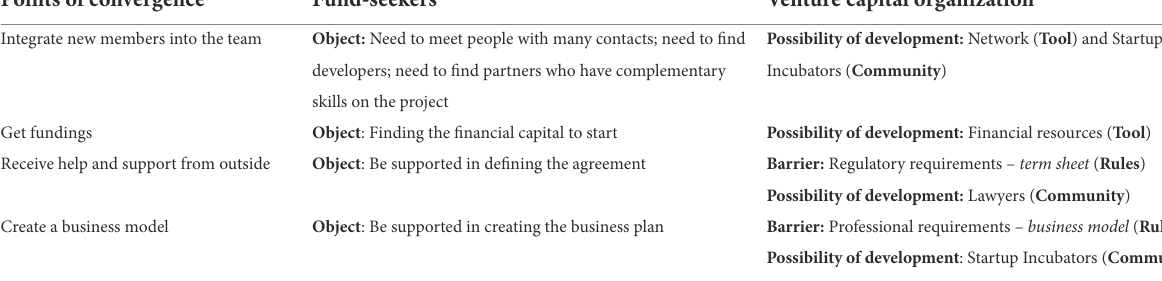
TABLE 1 Points of convergence between activity systems in the field of startup fundings. Points of